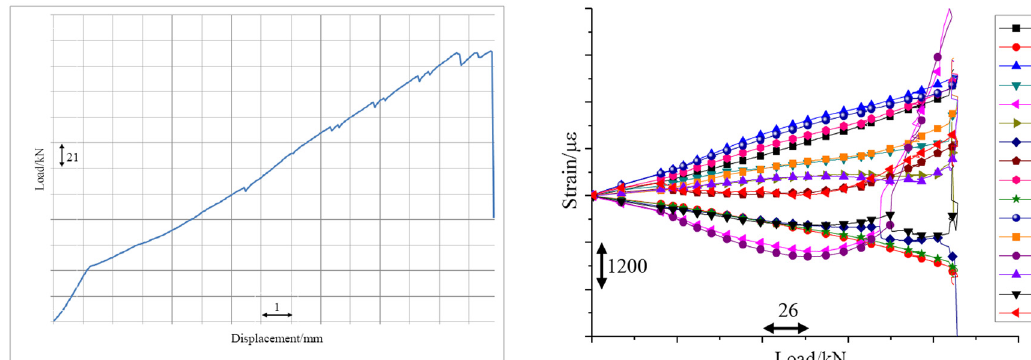
Figure 5: a3 - type test curve.